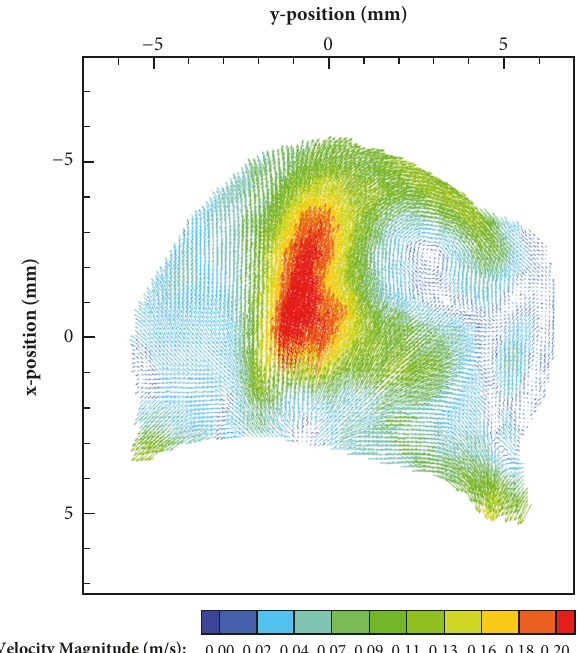
Figure 4: Example flow slice from the PIV